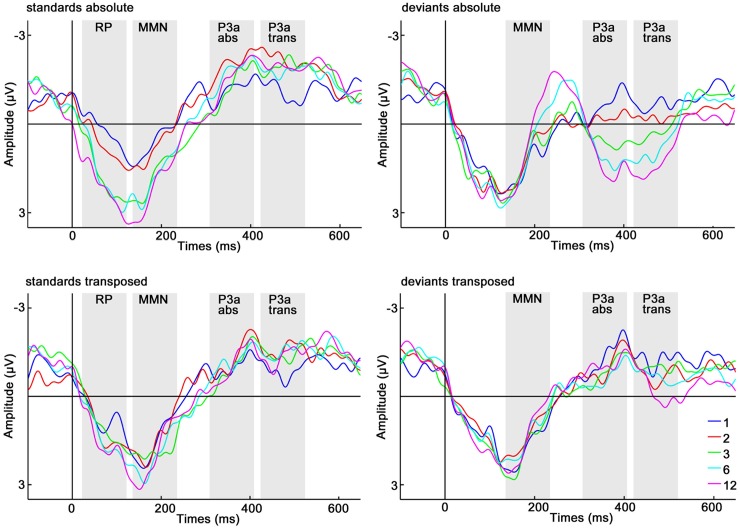
Grand-averaged (N = 18) ERPs for single train-lengths.Waveforms of standards at positions 1 (blue), 2 (red), 3 (green), 6 (light blue) and 12 (pink) and of deviants after standard positions 1, 2, 3, 6, and 12 for the absolute (abs) and transposed (trans) repetition condition at electrode Cz are shown. Grey shades indicate 100 ms time windows for RP, MMN and P3a in the absolute and the transposed repetition condition.